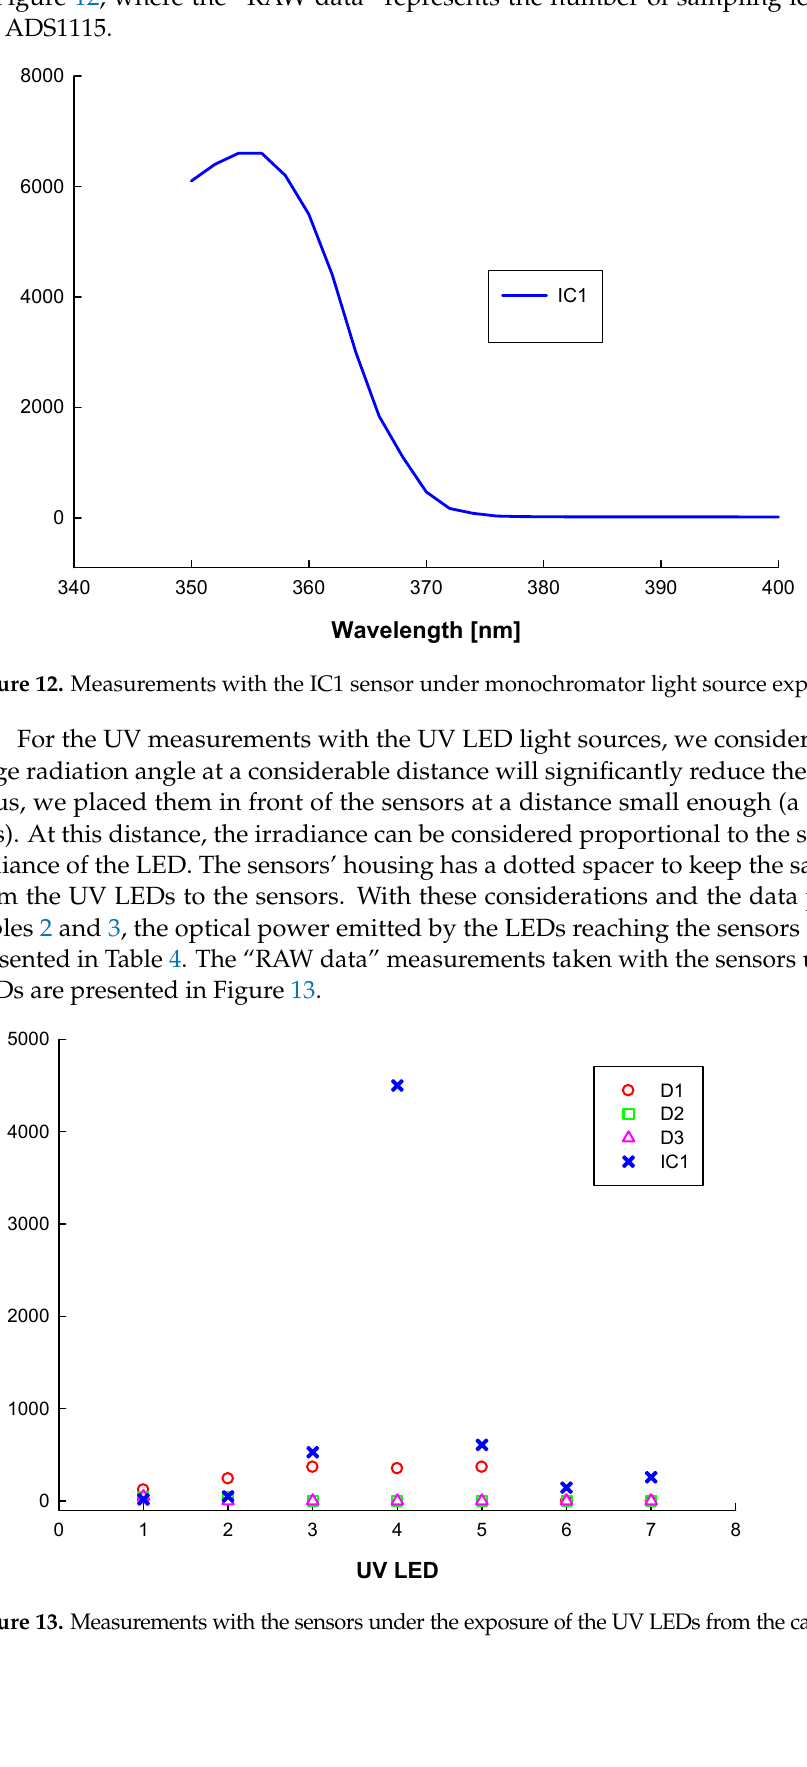
Figure 13. Measurements with the sensors under the exposure of the UV LEDs from the calibrator